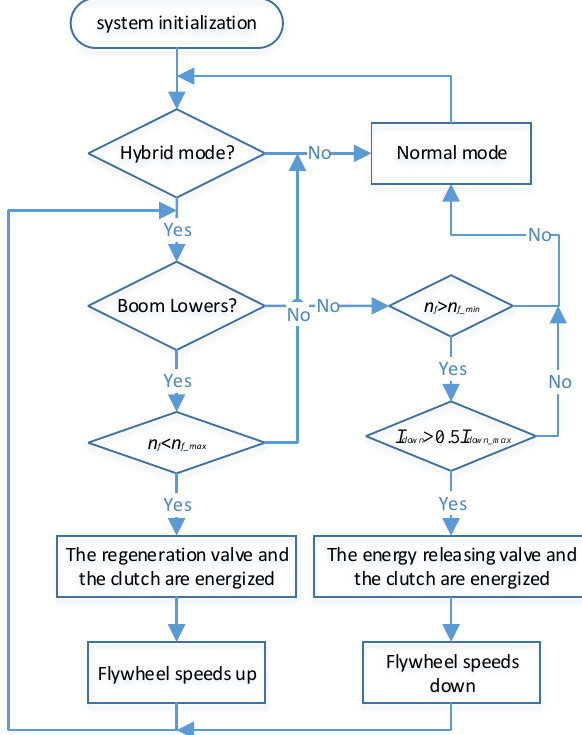
Figure 4. A flow chart of the control strategy.